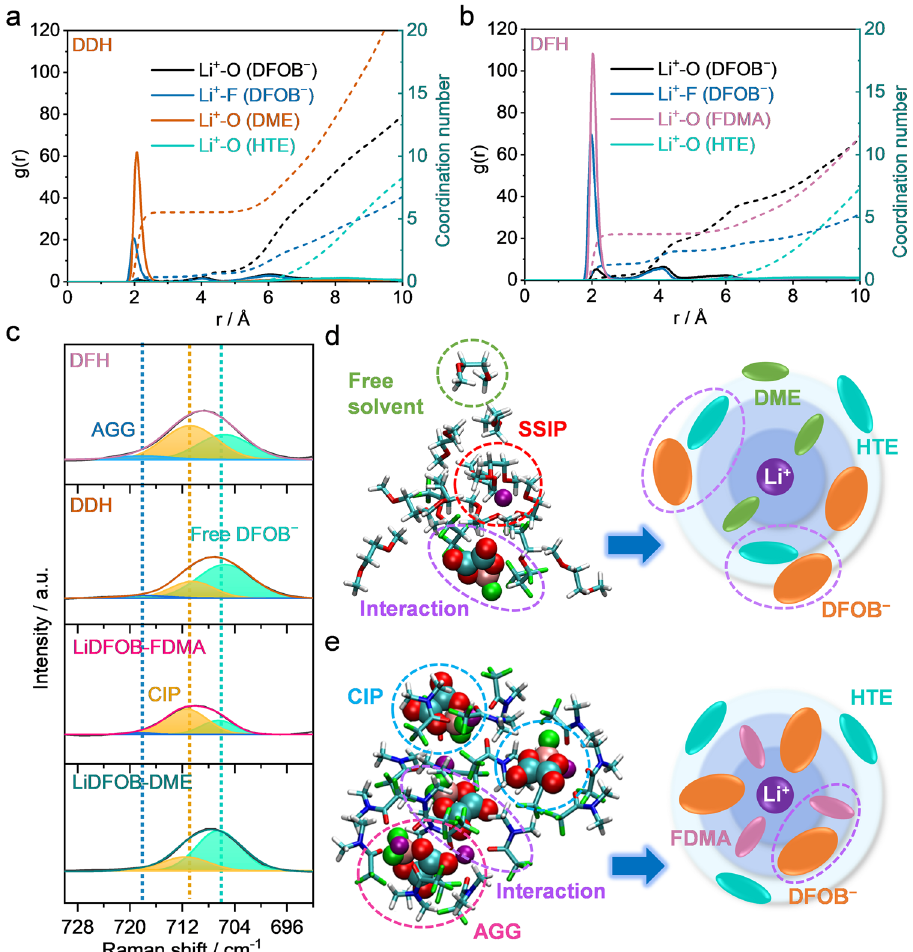
Fig. 2 Coordination solvation chemistry for electrolytes. Li + radial distribution function obtained from MD simulations of a DDH and b DFH electrolytes. Solid lines represent g(r) while dash lines represent coordination number. c Raman spectra of LiDFOB-DME, LiDFOB-FDMA, DDH, and DFH electrolytes. Li + -solvated structure in d DDH and e DFH electrolytes after simulation and the corresponding 2D schematic dia-